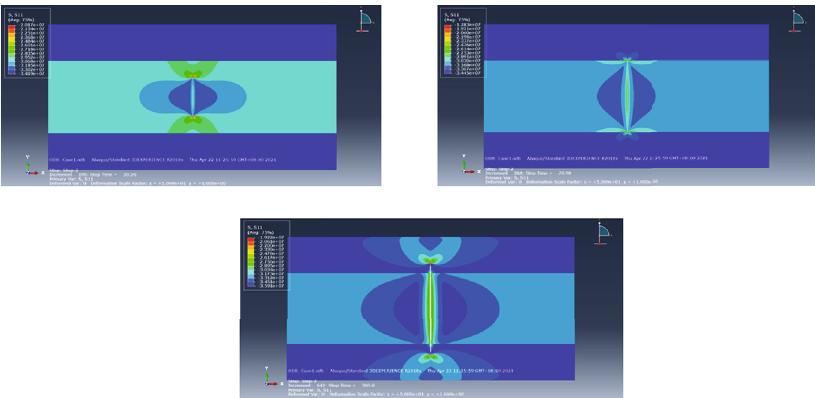
Figure 5: Height growth process in the reservoir without mud interlayers.